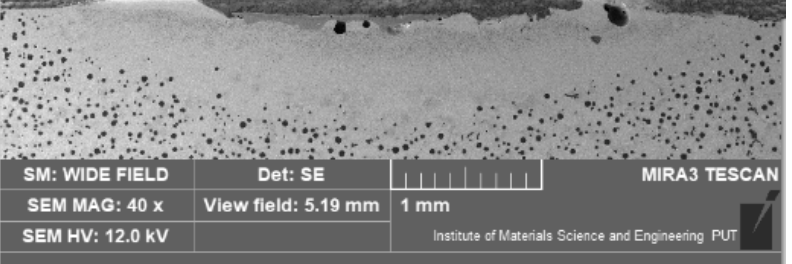
Figure 9. The cross-section of the surface layer of nodular iron after laser alloying with titanium (electron scanning microscope, etched with nital 3%).